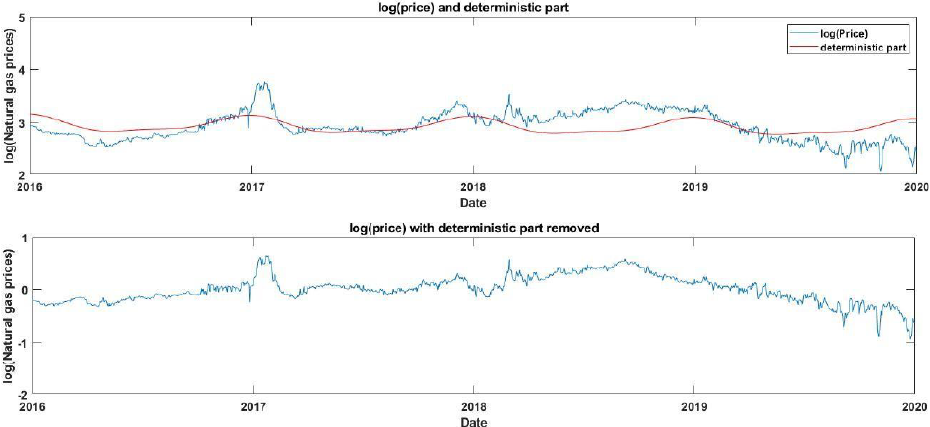
Figure 5. Daily natural logarithm of Spanish natural gas prices from 2016 to 2019 with their deter- ministic and stochastic